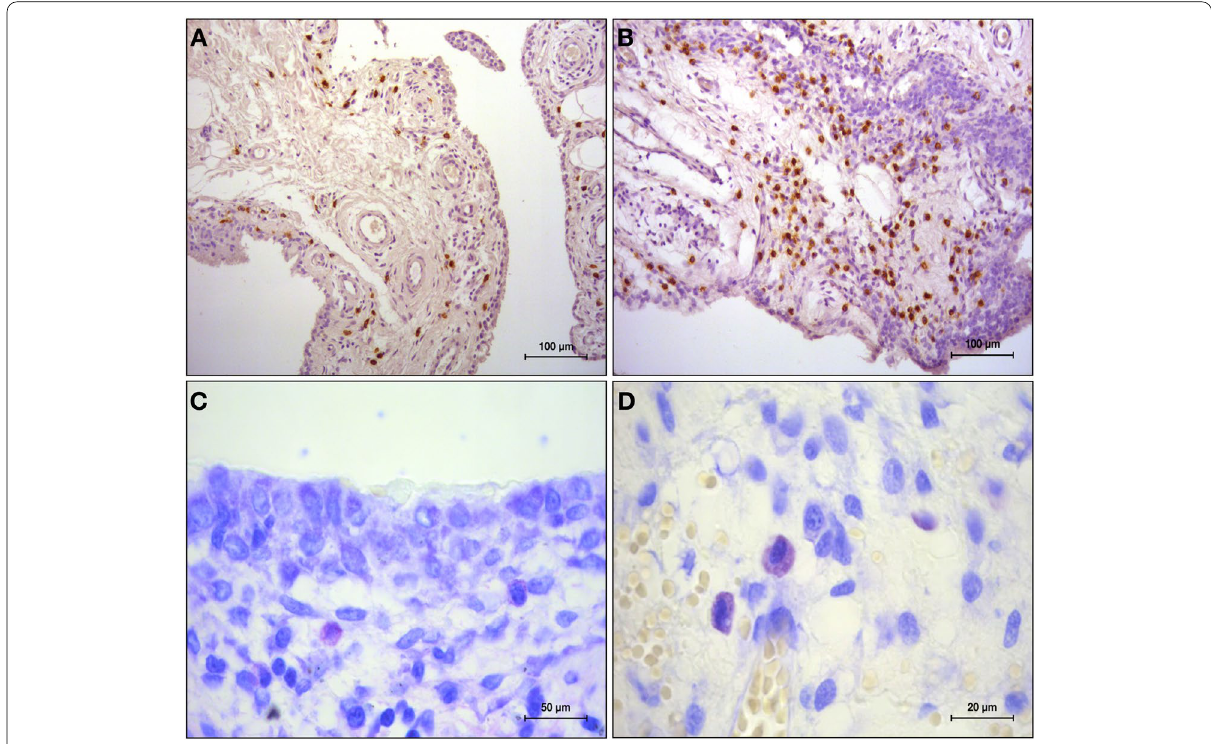
Fig. 3 Sample from a patient with knee osteoarthritis. Paraffin sections stained for CD117 ( A , B ) and toluidine blue ( C , D ). A and B , 20